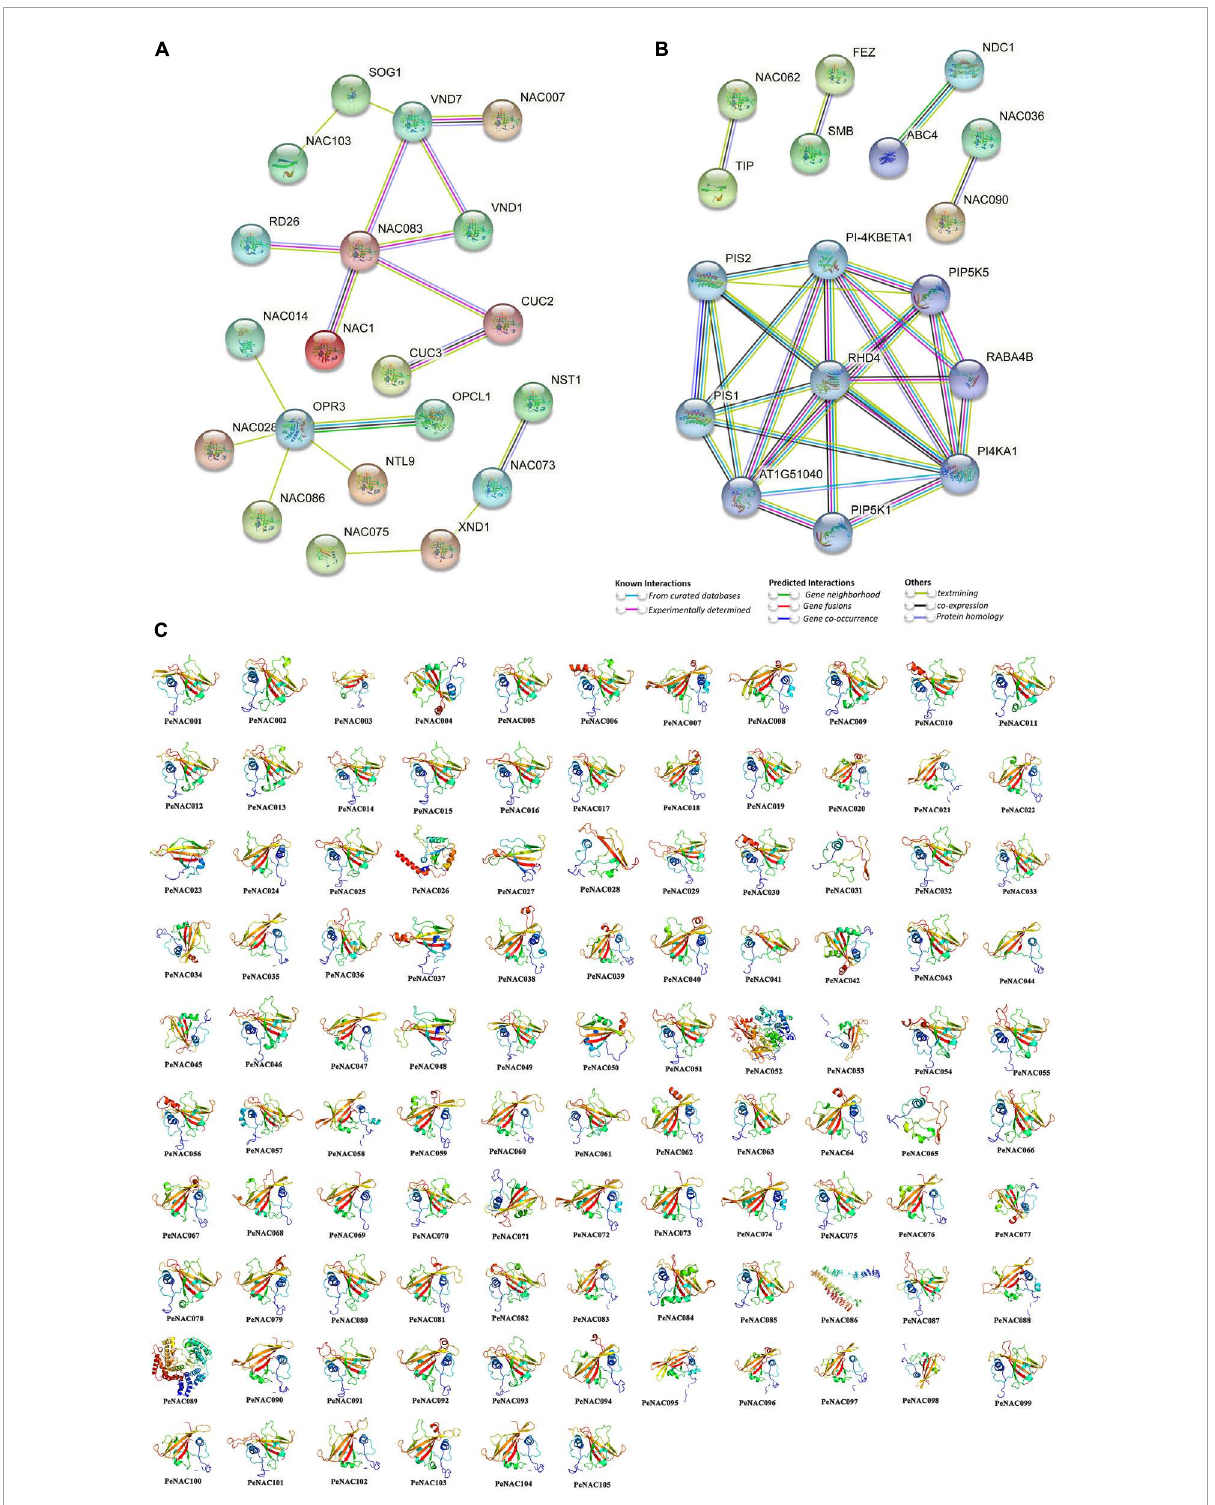
FIGURE6 Protein–protein interaction and predicted 3D models of PeNAC proteins. (A) Medium confidence interaction (0.4). (B) High confidence interaction (0.7). (C) 3D models of PeNAC proteins were constructed using the online Phyre2 server with default mode.